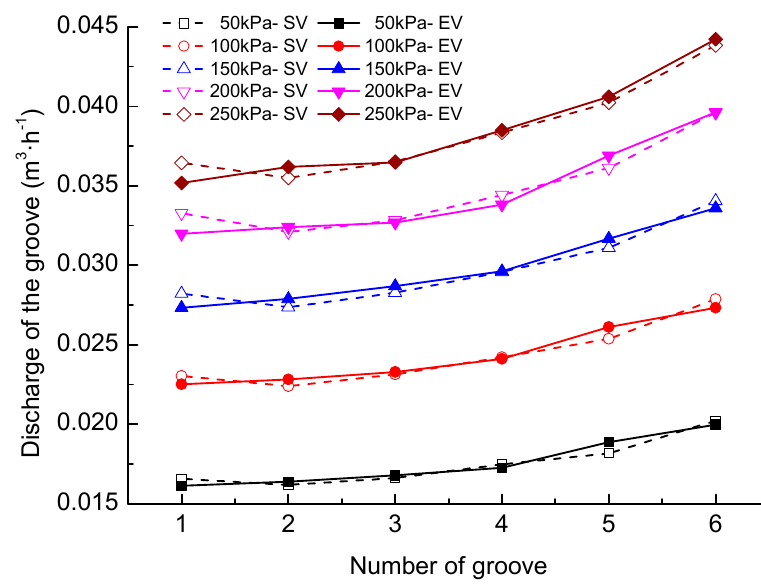
Figure 5. Jet flow rates for various numbers of grooves. SV, simulation value; EV, experimental value. Table 2. Initial trajectory velocity (m/s) with various numbers of grooves corresponding to a 4.98-mm nozzle at different working pressures.